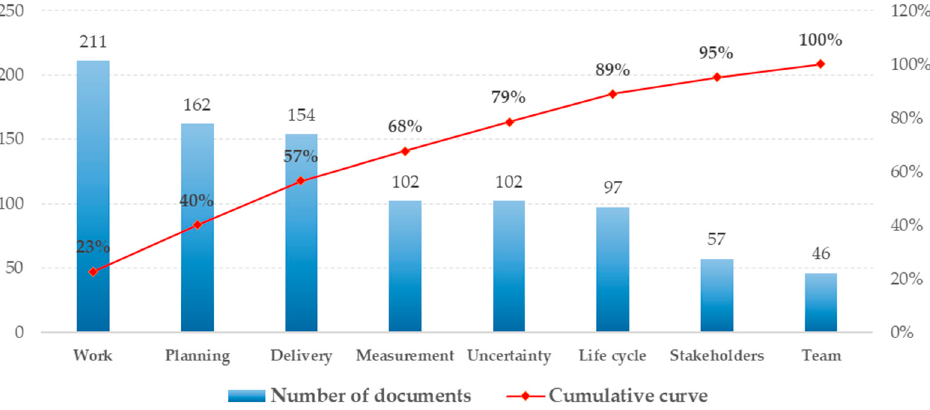
Figure 3. Number of documents by domain.